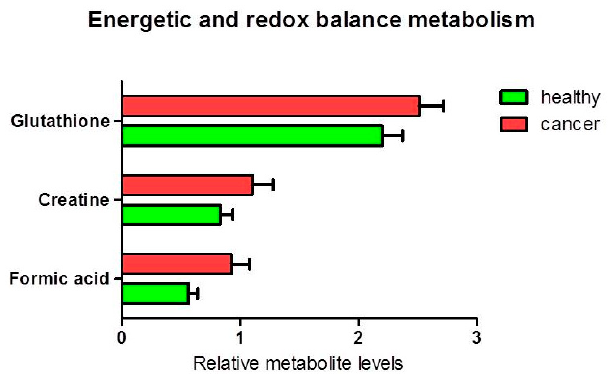
Figure 5. Percentage of metabolites (nmoles of metabolite relative to total nmoles of metabolites per g of tissue) involved in lipid metabolism in thyroid cancer tissue ( n = 11) and healthy thyroid tissues ( n = 10). The tendencies of variation of metabolites between healthy and cancer tissues were not statistically significant (highest ANOVA F 1,17 = 4.05; p = 0.060 for citrate).